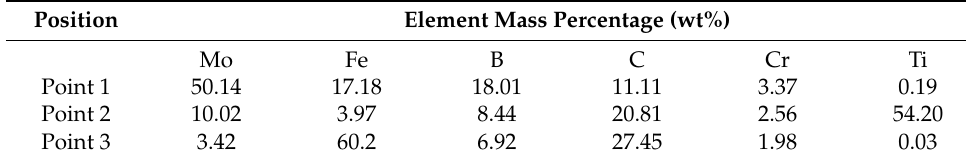
Figure 5. SEM analysis of claddings with 15% TiC contents and EDS line scan analysis.